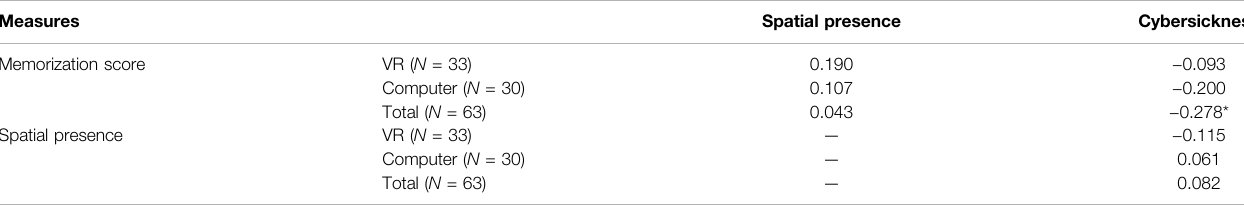
TABLE 3 | Correlations of the main variables for participants in VR and computer condition.